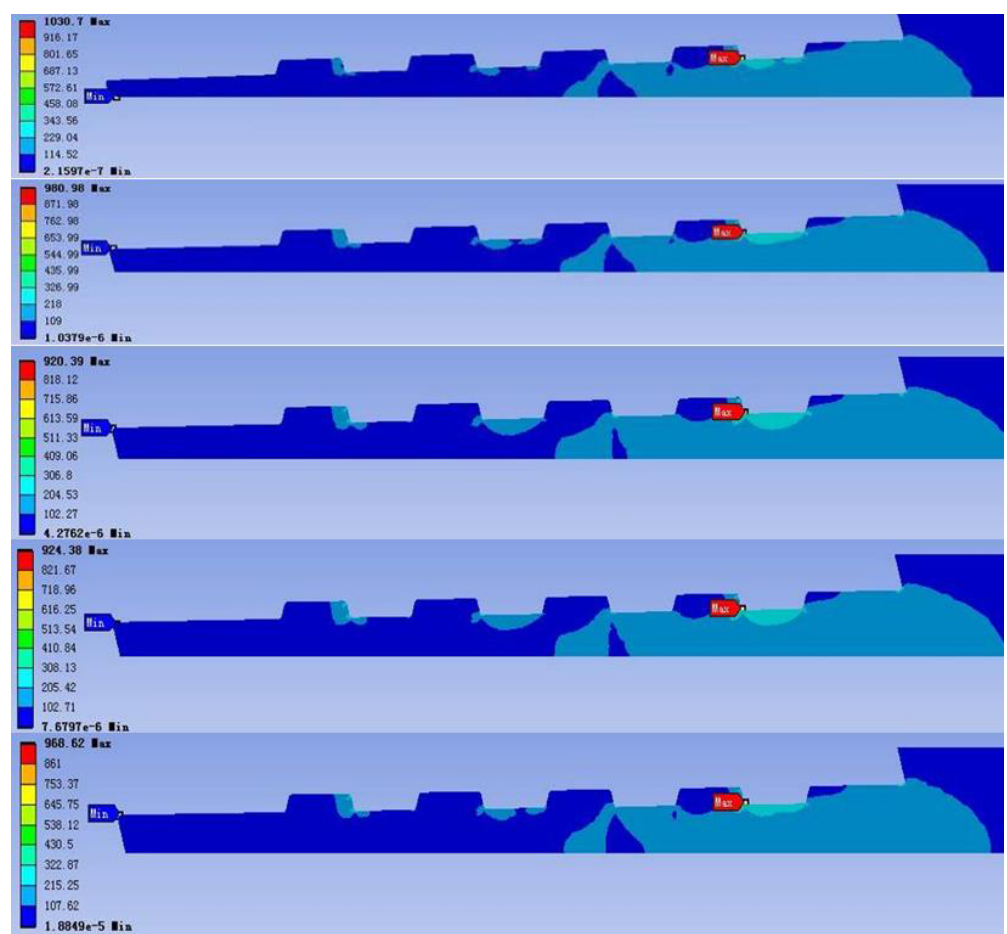
Figure 12. The stress nephogram of the external thread of the confining probe joint (the tapers from top to bottom are 1 : 15, 1 : 20, 1 : 25, 1 : 30, and 1 :